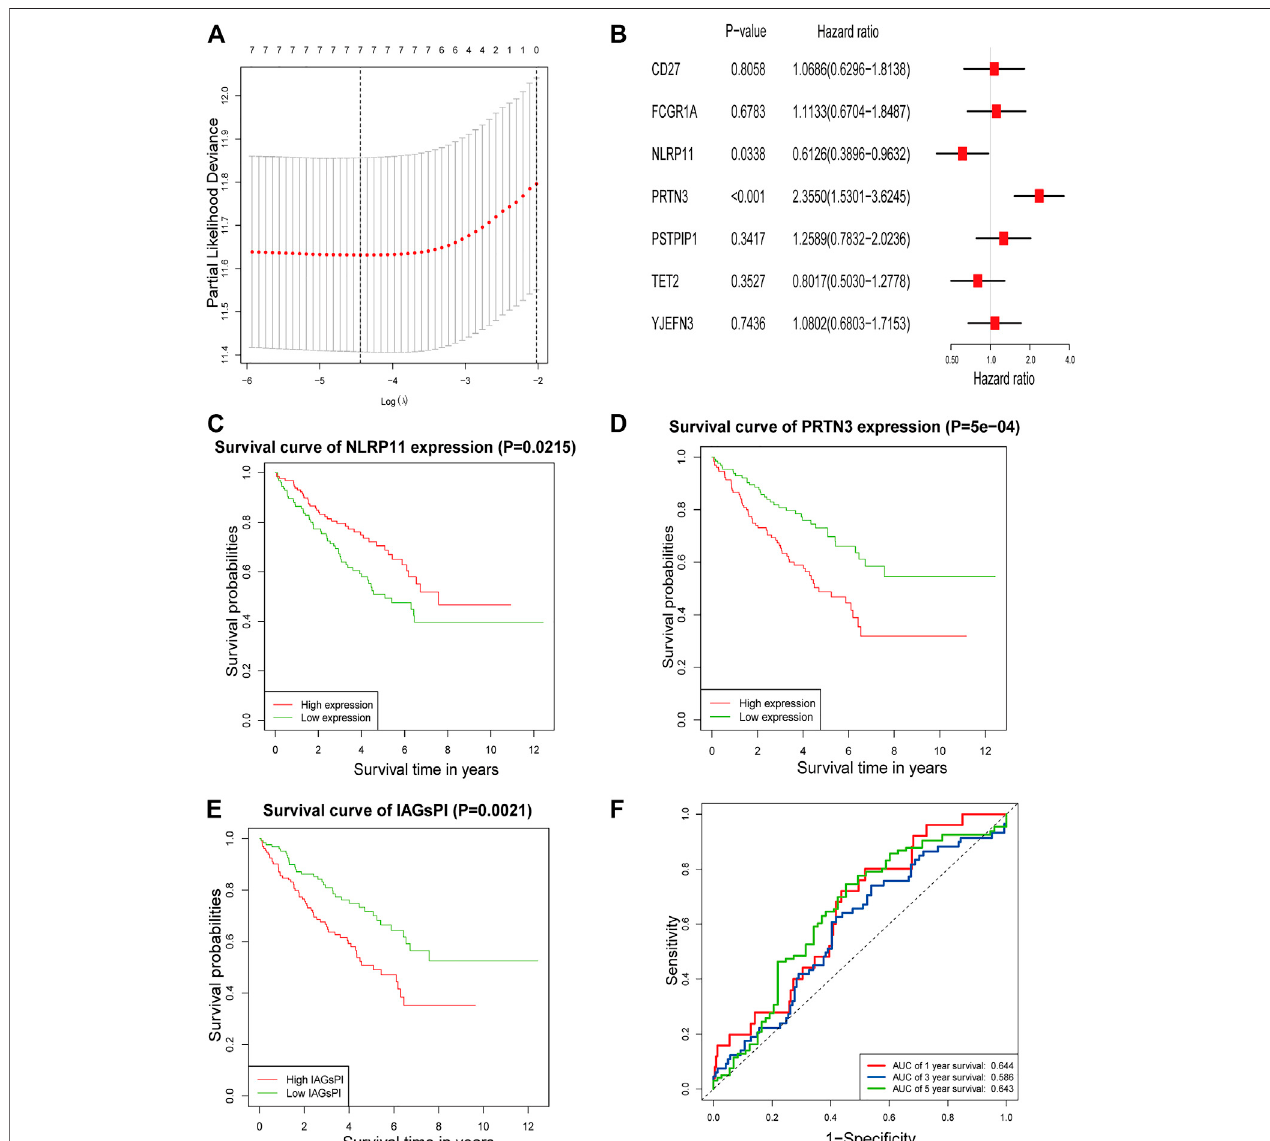
FIGURE 5 | Screening IAGs that were highly related to PAGs and development of a IAGsPI. (A) The results of LASSO regression analysis, identifying minimum criteria. (B) TheresultsofmultivariateCoxregressionanalysison7IAGswereusedtoidentifyindependentprognosticimmunegenes,andthecorrespondingcoef fi cients of the 7 IAGs were calculated. (C – E) KM survival analysis for NLRP11, PRTN3 and IAGsPI, respectively. (F) Prediction of ROC curve based on IAGsPI ’ s 1-year, 3-year and 5-year survival rate.